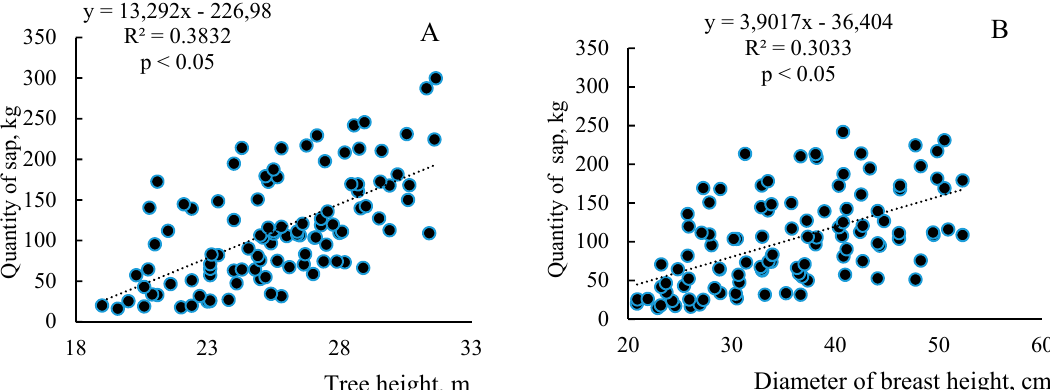
Figure 3. The quantity (kg) of sap collected from silver birch ( Betula pendula ) trees ( n = 103) of di ff erent heights ( A ), diameters at breast height ( B ).